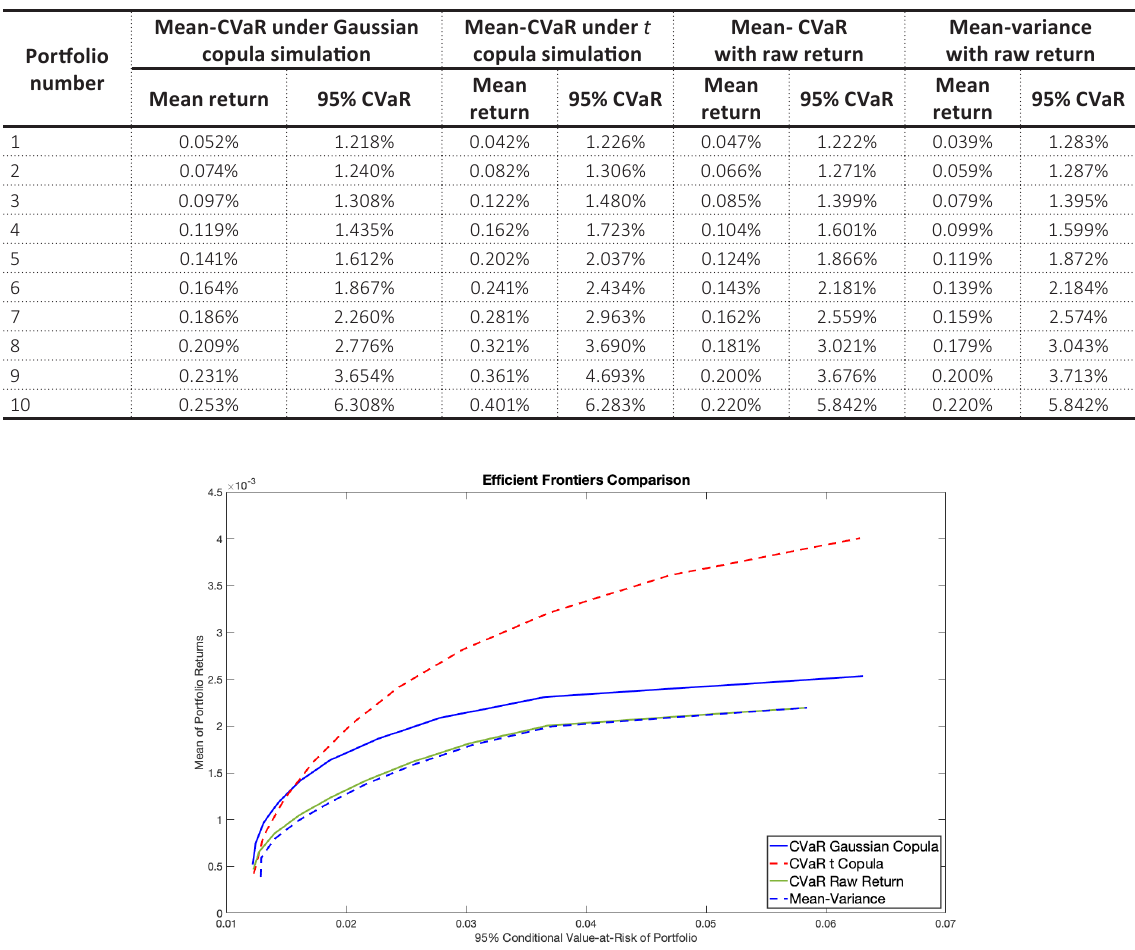
Portfolio number